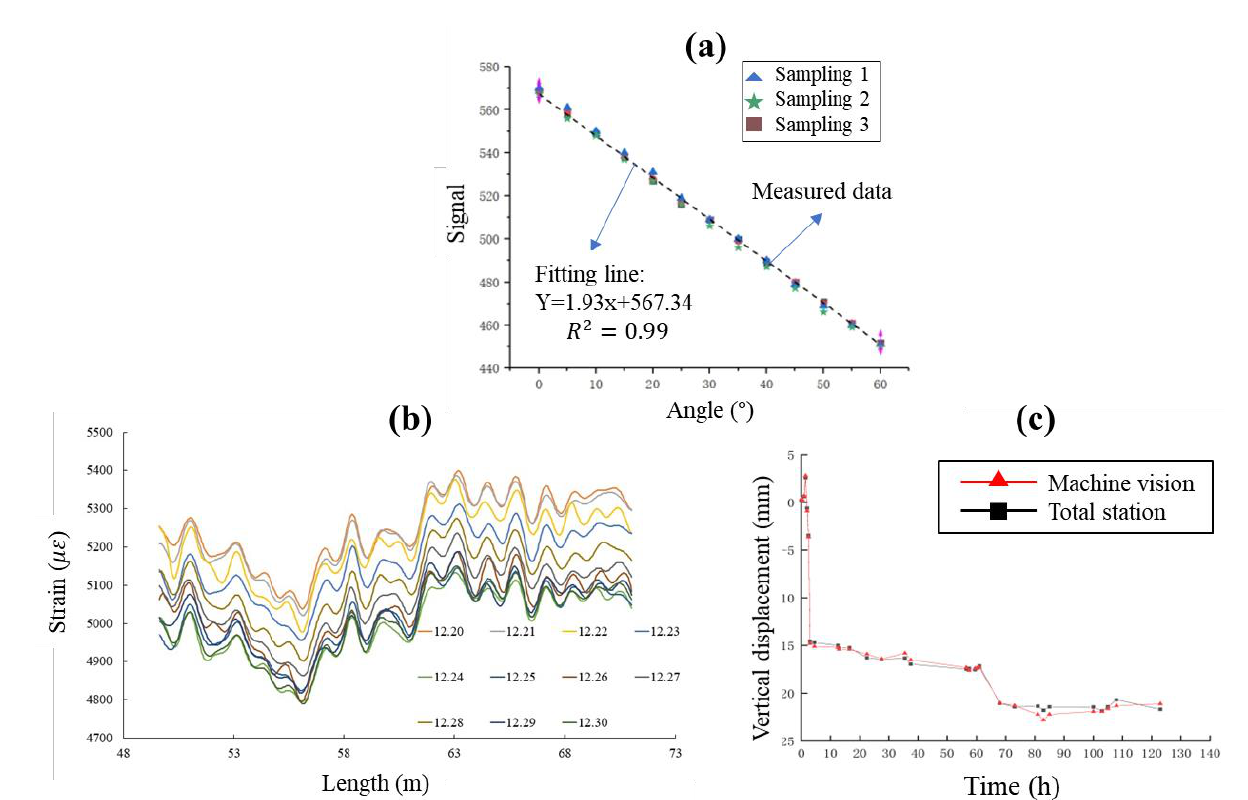
Figure 6. ( a ) Typical calibration results for MEMS technology. ( b ) Representative BOFDA results for ZC1-2. ( c ) Measurement comparison between machine vision and total station.